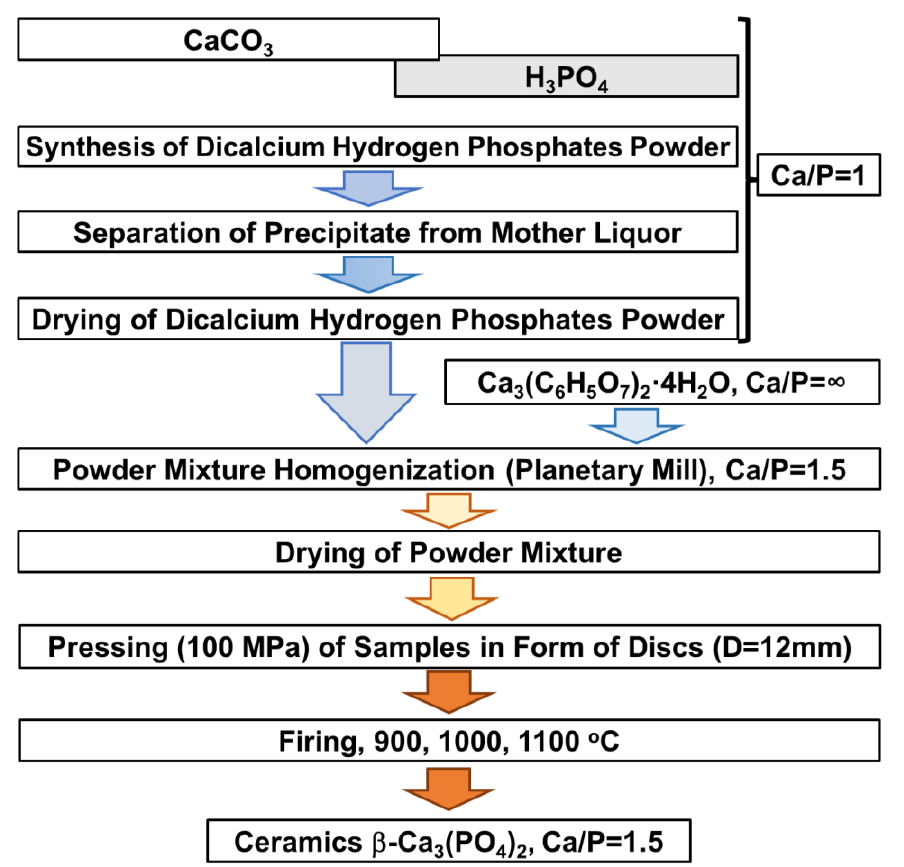
Figure 1. Scheme of microporous ceramic sample preparation.